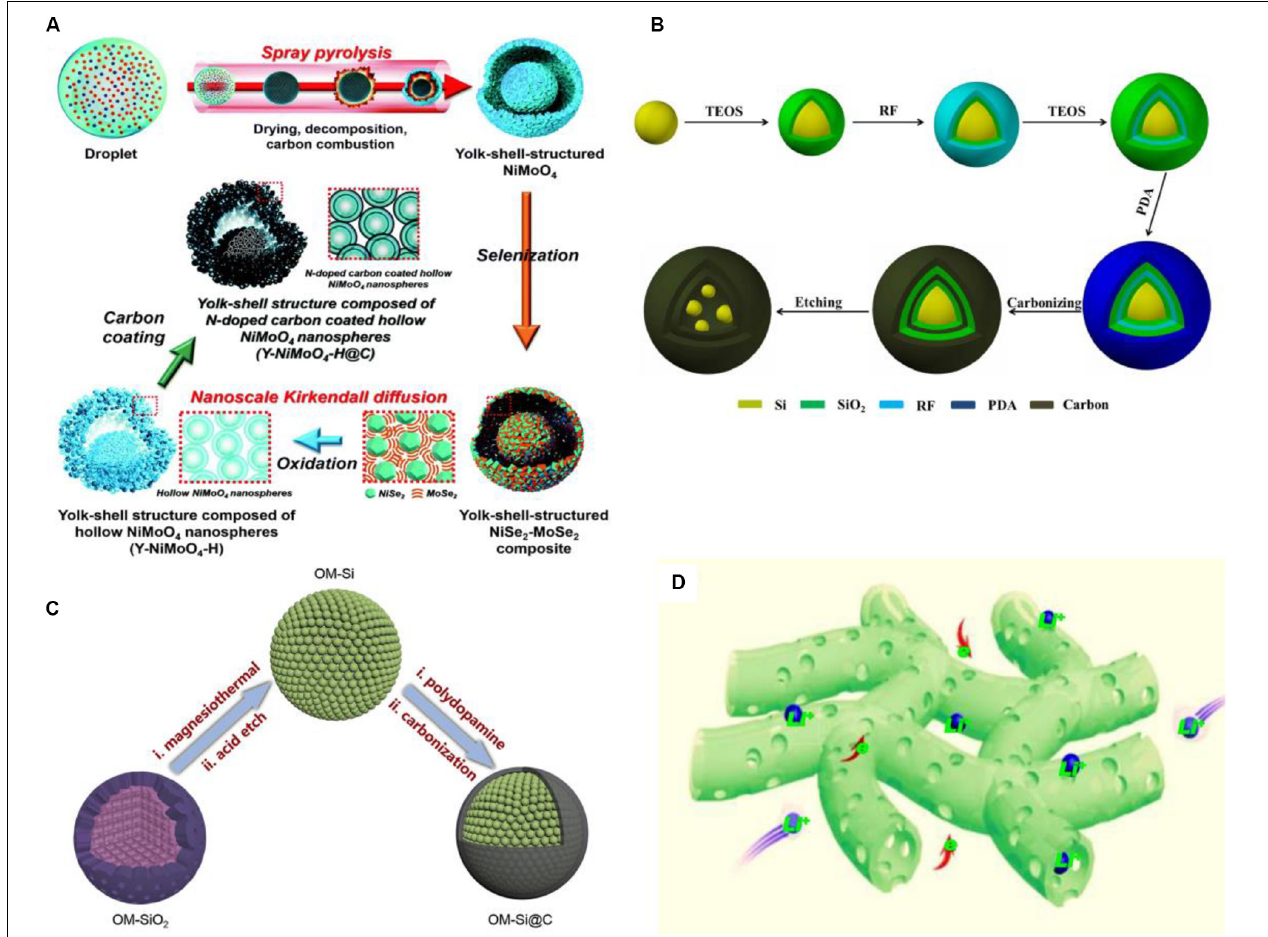
FIGURE 11 | The structure models and formation mechanism of various composite electrodes by surface carbon coating with representative structure. (A) N-doped carbon coated hollow NiMoO 4 nanospheres with yolk-shell structure. Reproduced with permission from Ref. Park et al. (2019). Copyright 2019 Royal Society of Chemistry. (B) Si/C composites with yolk-shell structure. Reproduced with permission from Ref. Hu et al. (2019). Copyright 2018 Elsevier. (C) OM-Si@C composites with core-shell structure. Reproduced with permission from Ref. Duan et al. (2019). Copyright 2019 Elsevier. (D) The nanoscale porous CNFs electrode with successive electron and Li + transfer channels. Reproduced with permission from Ref. Zheng et al. (2019). Copyright 2019